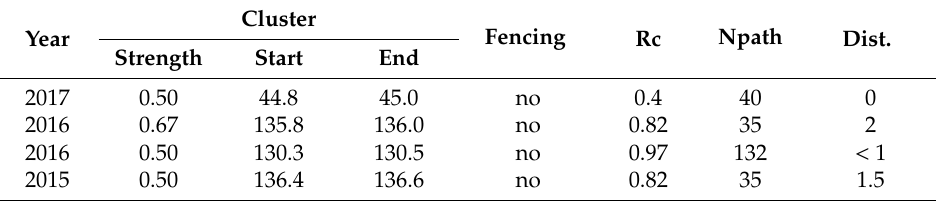
Table 2. Evaluation of the prognostic possibilities of the moose movement model for highway A1, comparing with MVC clusters for every year in 2015–2017: Bandwidth 150 m, Rc—cumulative segment rank, Npath—number of pathways crossing the segment. Dist.—distance (km) between cluster and nearest Rc / Npath